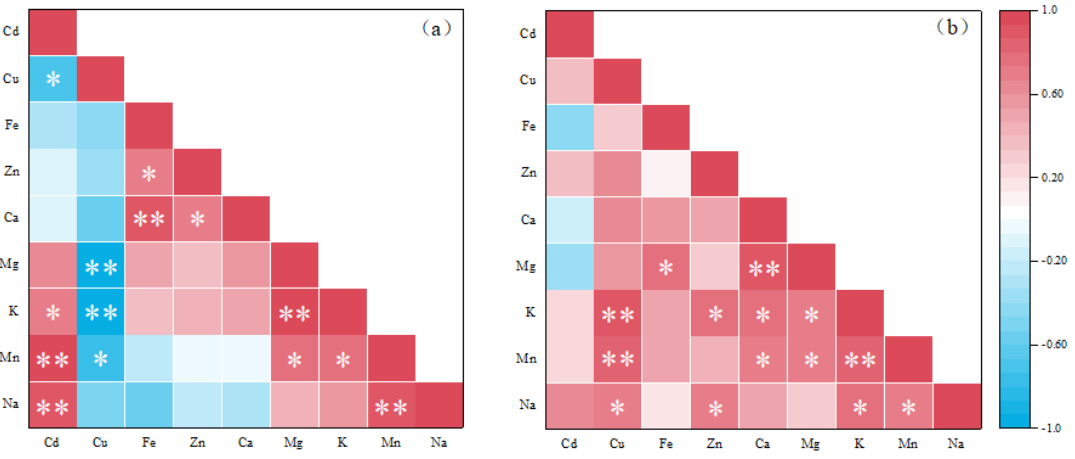
Figure 5. Pearson correlation between antioxidant enzyme activity, heavy metals and mineral elements in Brassica leaves ( a ) and roots ( b ). (significant correlation between * and ** at p ≤ 0.05 and p ≤ 0.01, respectively).